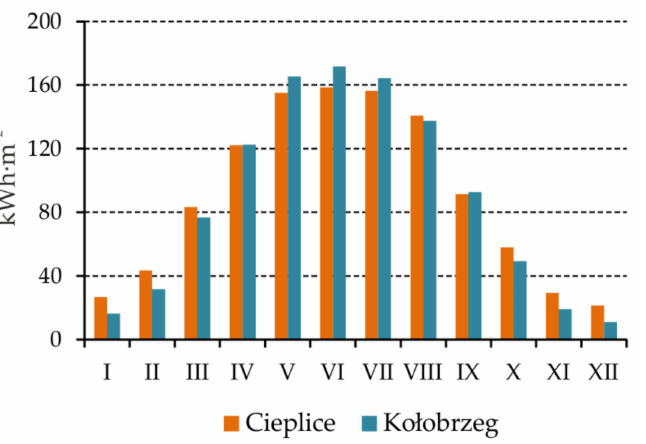
Figure 8. The annual course of the monthly mean sums of global solar radiation in Cieplice and Kołobrzeg. Data for the years